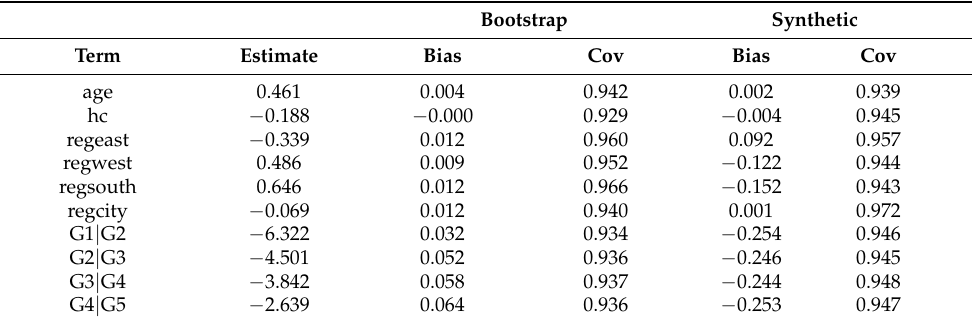
Table 5. Simulation results for a proportional odds logistic regression model with continuous and ordered categorical predictors. The model evaluated is gen true data estimates and the bias from the true data estimates and the coverage rate of the 95% confidence interval for the bootstrap and synthetic data sets.